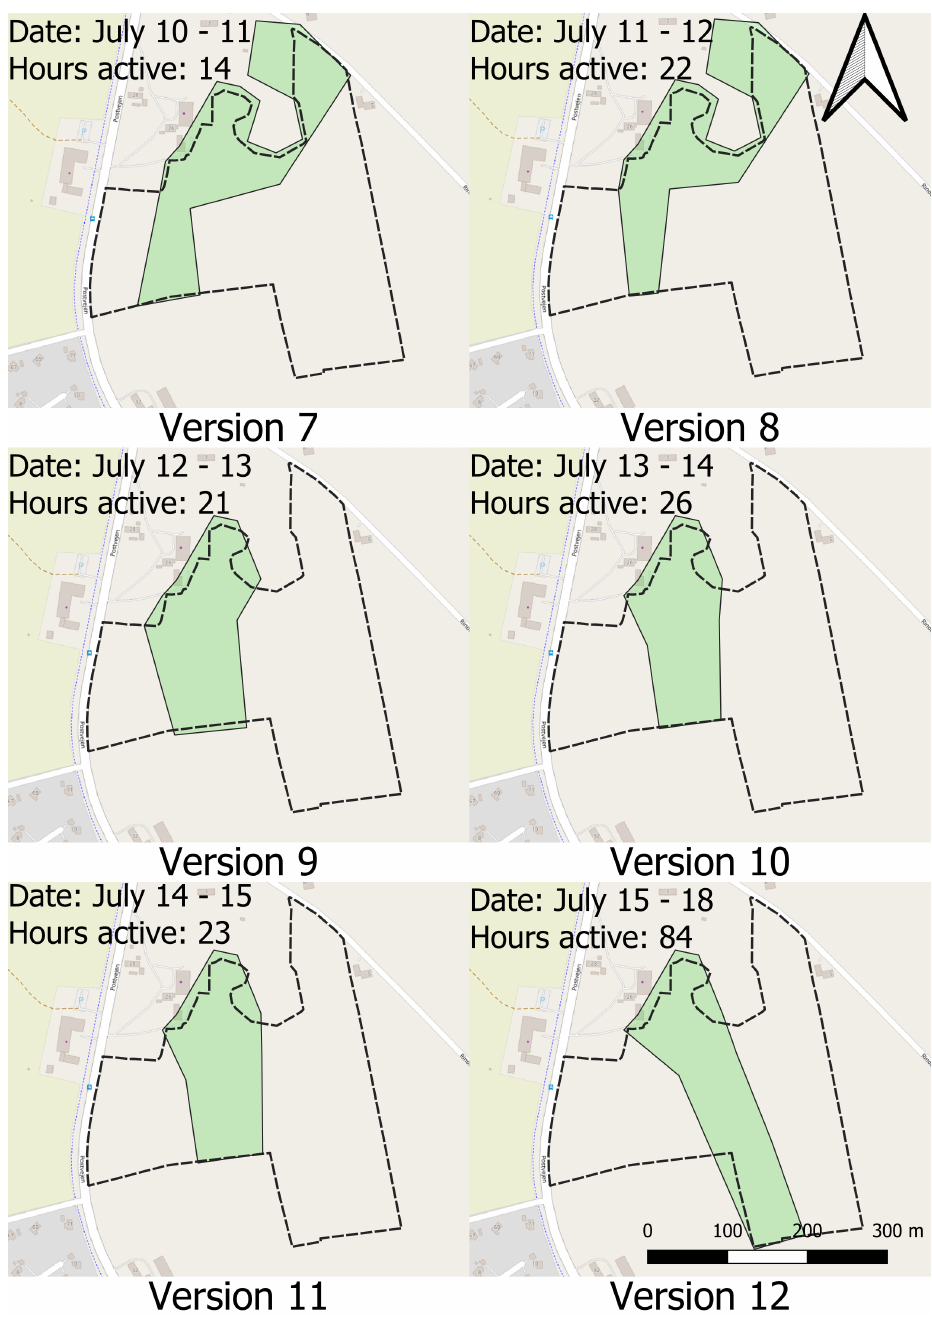
Figure A2. Virtual enclosure version 2 dating from 10 July to 18 July. The dashed black line represents the physical fence surrounding the 8.2 ha grazing area. The marked green area represents the virtual enclosure. Only virtual enclosures active for more than 12 h were included. The coordinates of the up- per left corner of the map frame are 55°25 (cid:48) 23.131 (cid:48)(cid:48) E 8°23 (cid:48) 53.531 (cid:48)(cid:48) N. Map data from OpenStreetMaps